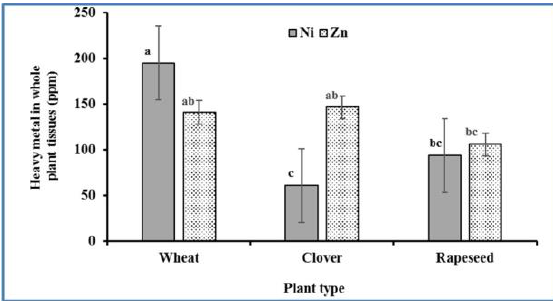
Figure 1. The interaction of plant and element type on the uptake of heavy